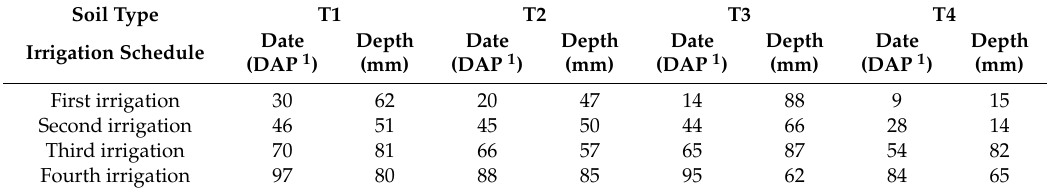
Table 3. Optimal irrigation schedules under di ff erent soil types in Danman Irrigation District in